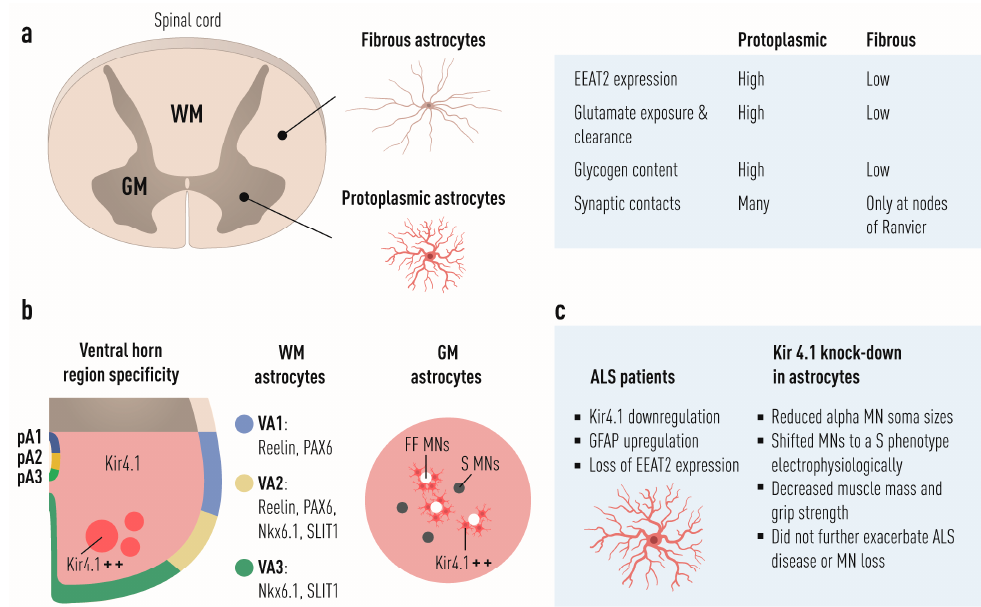
Figure 5. Dorsoventral astrocyte diversity in the spinal cord and implications for differential spinal motor neuron vulnerability in ALS. ( a ) Astrocytes are subdivided into fibrous, in the white matter (WM), and protoplasmic, in the gray matter (GM). These differ in their EEAT2 expression, glutamate exposure and clearance, glycogen content, and synaptic contacts. ( b ) Astrocytes within the WM show regional specificity and arise from three progenitor domains, p1, p2, and p3. These subtypes can be identified on the basis of their expression of PAX6, NKX6.1, and the cell surface markers, reelin and SLIT1. Specifically, dorsally located VA1 astrocytes, derived from the p1 domain, express PAX6 and reelin; ventrally located VA3 astrocytes, derived from the p3 domain, express NKX6.1 and SLIT1,]; and intermediate WM-located VA2 astrocytes, derived from the p2 domain, express PAX6, NKX6.1, reelin, and SLIT1 [136]. GM astrocytes also show regional specificity with clear differences in KIR4.1 (KCNJ10) expression, with ventral horn astrocytes exhibiting higher expression of KIR4.1 than dorsal horn astrocytes. Within the ventral horn, WM astrocytes surrounding FF MNs show the highest level of KIR4.1 (KIR4.1 ++ ) and those surrounding S MNs show a lower level of KIR4.1. ( c ) ALS patient astrocytes show decreased expression of KIR4.1, GFAP upregulation and loss of EEAT2 expression. Removal of KIR4.1 from astrocytes in mice affected α MN soma sizes and shifted electrophysiological properties to a more slow-like MN phenotype with an accompanying decrease in muscle mass and grip strength. Overexpression of KIR4.1 specifically in astrocytes was sufficient to increase the size of both FF and S MNs. However, loss of KIR4.1 in astrocytes in the SOD1 G93A mouse did not further exacerbate MN death . Astrocytes promote neuronal survival, induce functional synapse formation (irrespective of the age of the host the astrocytes originate from), and engulf synaptosomes. Astrocytes are heavily involved in spatially regulating extracellular potassium concentrations through the expression of a number of potassium ion channels, KIRs (potassium inward rectifying channels). Repolarization of neurons tend to raise potassium concentrations in the extracellular fluid (which is normally low in potassium ions and high in sodium ions). If the rise is significant, it can interfere with neuronal